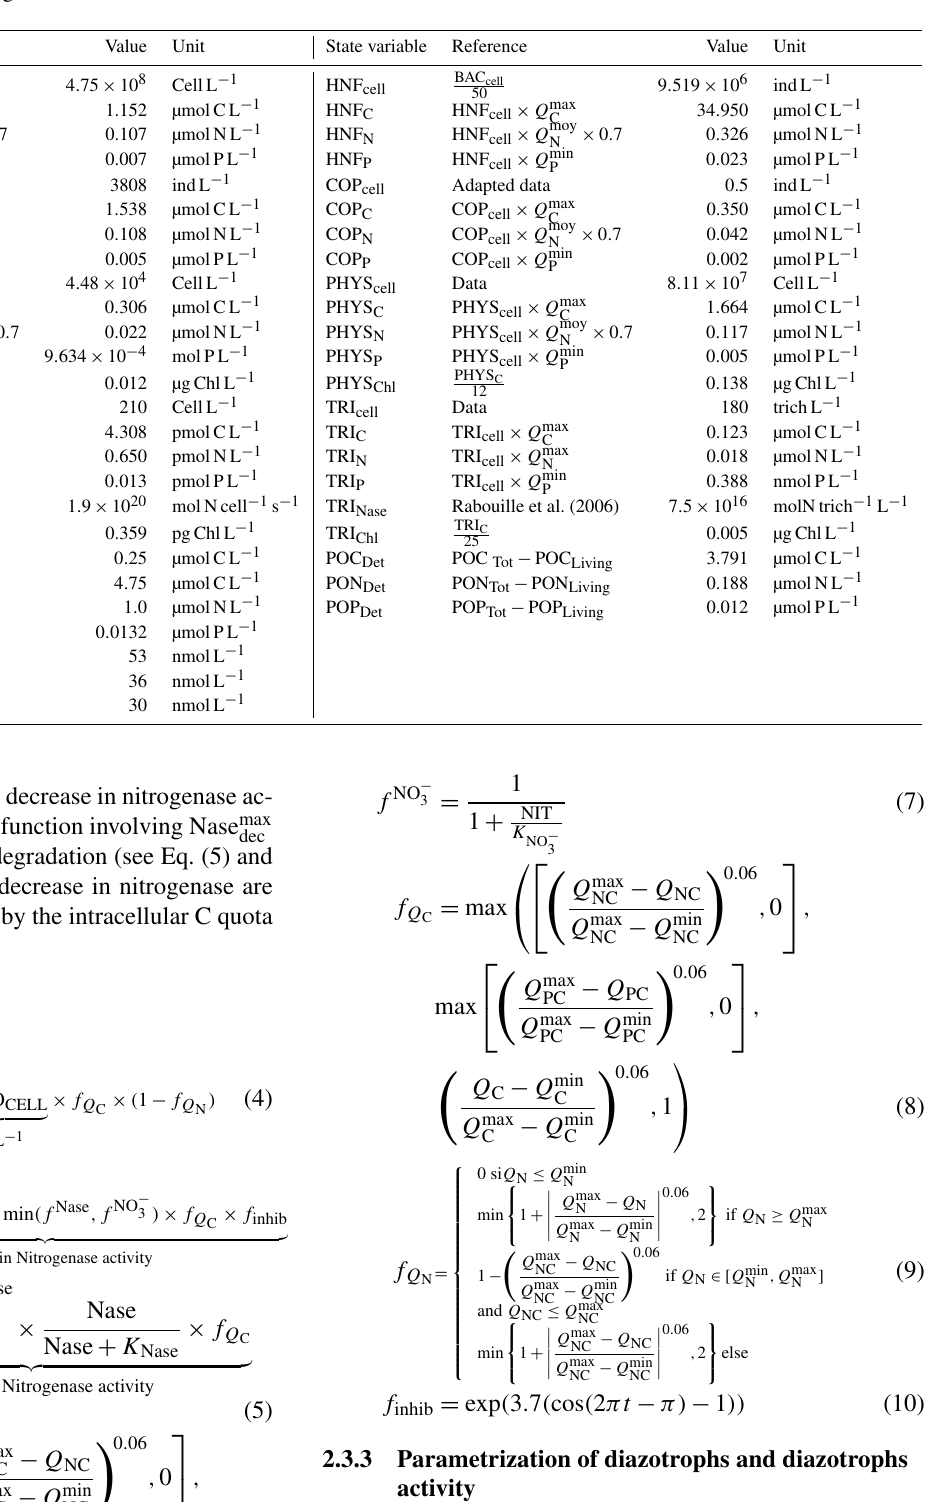
Table 1. Initial conditions for the biogeochemical